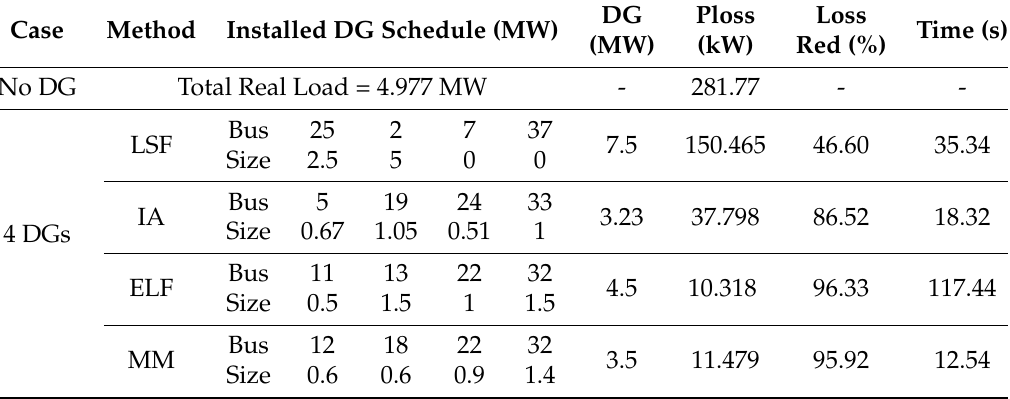
Table 2. DG placement by different methods for IEEE 37 node system at operational power